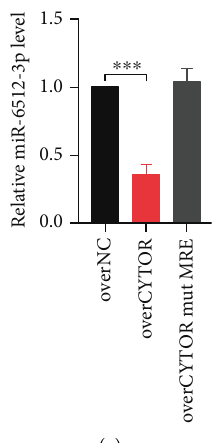
Figure 2: CYTOR directly binds to miR-6512-3p. (a) The Venn diagram showed the overlap of miRNAs which had potential binding sequences of CYTOR , based on several online systems. (b) The miR-6512-3p levels throughout the osteogenic di ff erentiation time course were detected by qRT-PCR. (c) The putative binding sites (blue color) and mutated binding sites (red color) between CYTOR and miR- 6512-3p were shown. The dual luciferase reporter constructs containing the wild type ( CYTOR -wt) or mutant CYTOR ( CYTOR mut). (d) CYTOR -wt or CYTOR mut was cotransfected into 293T cells with miR-6512-3p mimic or negative control, and Luciferase activity was detected. (e) RNA-binding protein immunoprecipitation (RIP) assay was performed by using the AGO2 antibody in PDLSCs. The enrichment of CYTOR and miR-6512-3p in AGO2-immunoprecipitated complexes were assessed by following qRT-PCR. (f) Positive control of RIP procedure. Anti-SNRNP70 served as a positive control antibody. (g) Level of miR-6512-3p was assessed by qRT-PCR in over CYTOR or over CYTOR mut MRE-treated hPDLSCs. ∗ p < 0 : 05 , ∗∗ p < 0 : 01 , and ∗∗∗ p < 0 : 001 , compared with the control group as